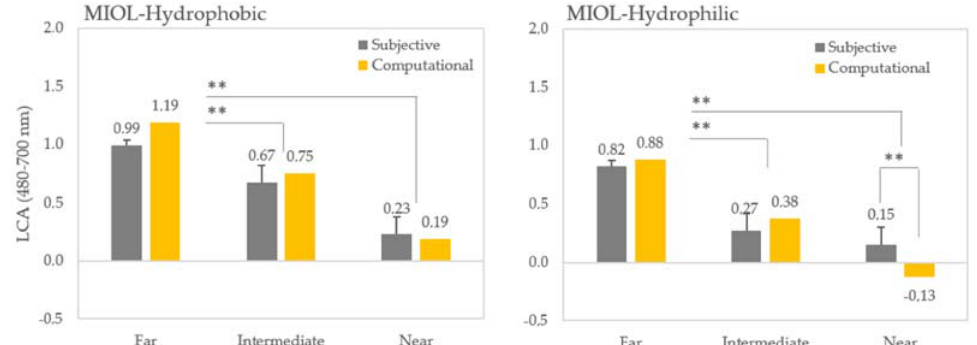
Figure 8. Average LCA (480–700 nm) for multifocal vision for hydrophobic and hydrophilic MIOLs from subjective (solid gray bars) and computational (solid yellow bars) methods for far, intermediate, and near vision. Error bars stand for inter-subject variability in all cases. ** Statistically significant ( p < 0.01) differences between conditions. Error bars indicate inter-subject variability.